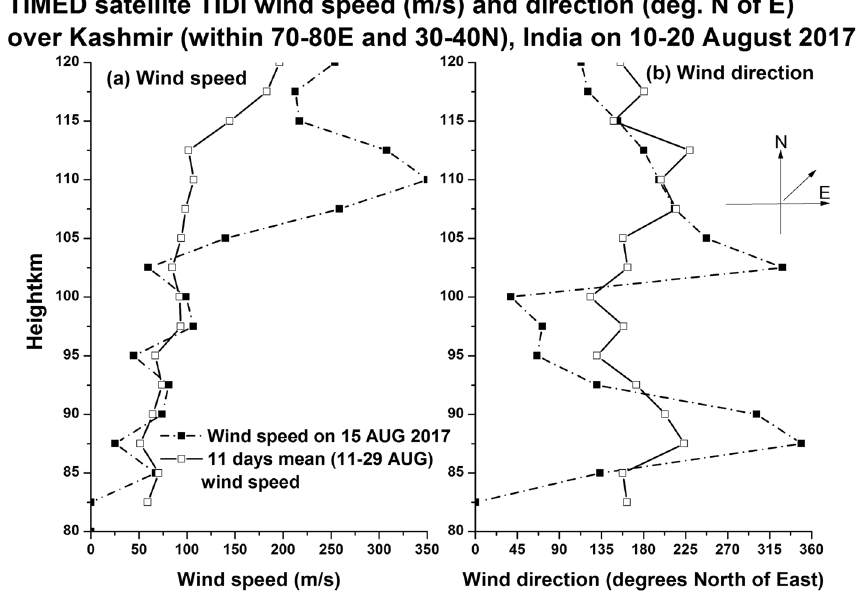
Figure 9. Provides the height profiles of horizontal wind speeds (m/s, TIDI-TIMED satellite data) at 12.6 UT on 15 August 2017 and on 10–20 August 2017 (11 days mean wind) for the longitude and latitude centred (± 5°) around the CCD imager site in Kashmir,